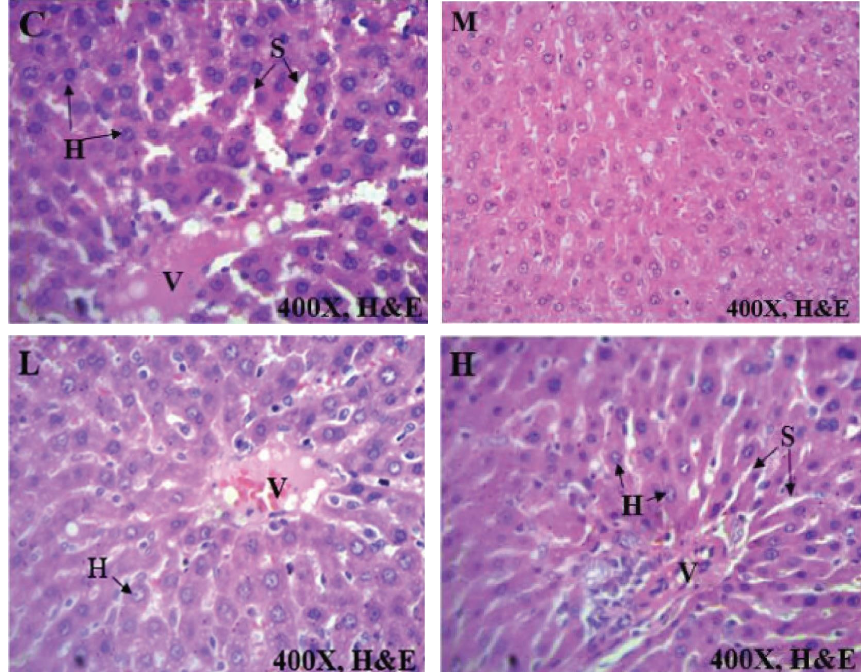
Figure 4: Efect of AAE on histological features of the liver, (C): control, L 100mgkg − 1 , M 300mgkg − 1 , and H1000mgkg − 1 . H-hepatocyte, S- sinusoids, and V-central vein of the lobule. Te photomicrographs (H&E, x400) of the liver tissues represent the general appearance observed in the rats treated with AAE and the control